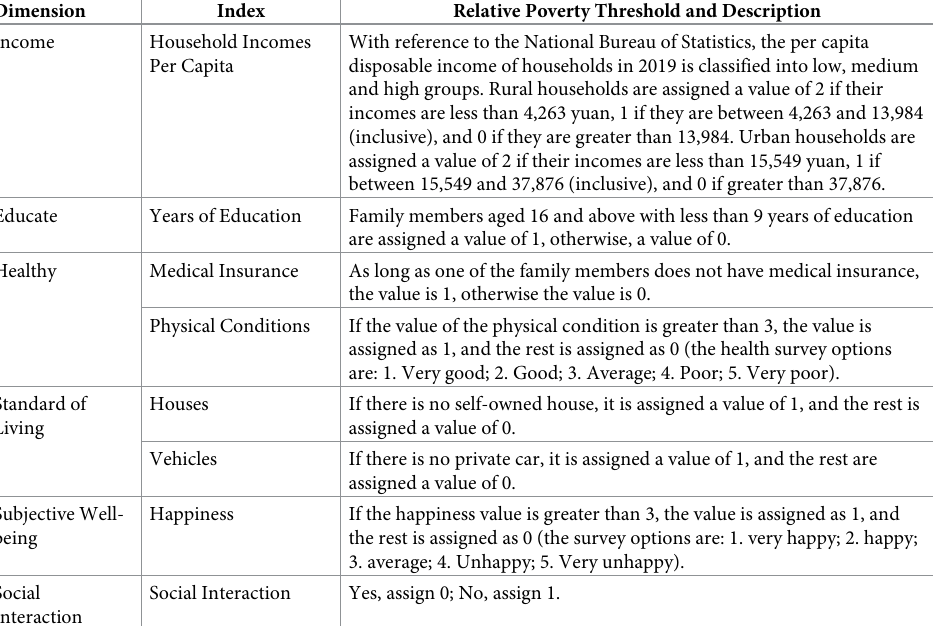
Table 2. Construction of multidimensional relative poverty indicators for